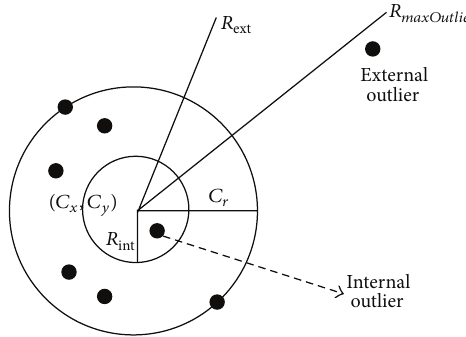
Figure 15: Outliers in doughnut formations.